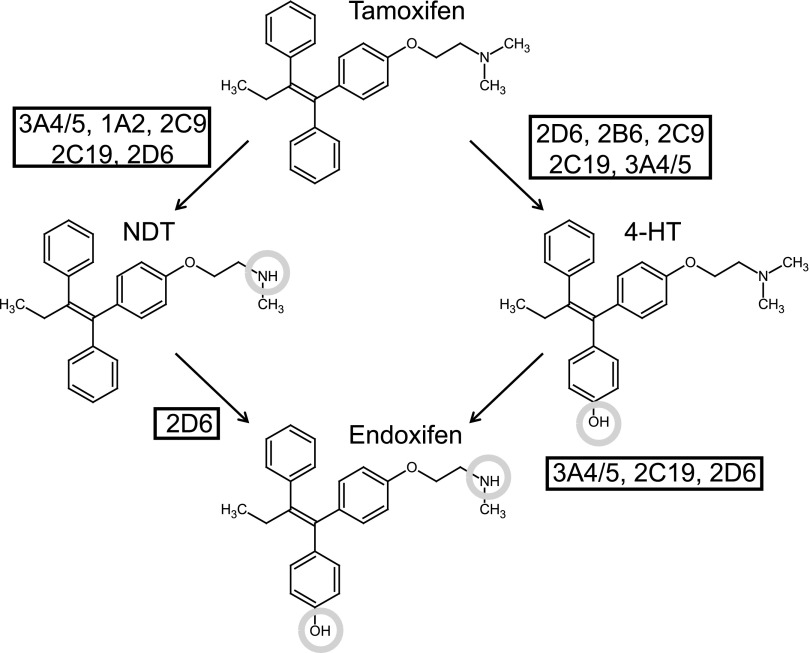
Phase I metabolism of tamoxifen. P450s metabolize tamoxifen through the “major” (N-demethylation followed by 4-hydroxylation) or “minor” (4-hydroxylation followed by N-demethylation) pathway, so denoted due to the relative abundance of each metabolite in plasma samples (Stearns et al., 2003; Madlensky et al., 2011). Conversion of NDT to endoxifen is catalyzed exclusively by CYP2D6 (Desta et al., 2004).